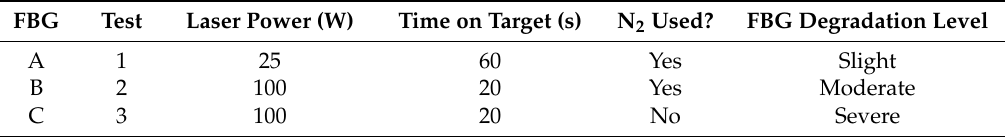
Table 3. FBG Testing Matrix.